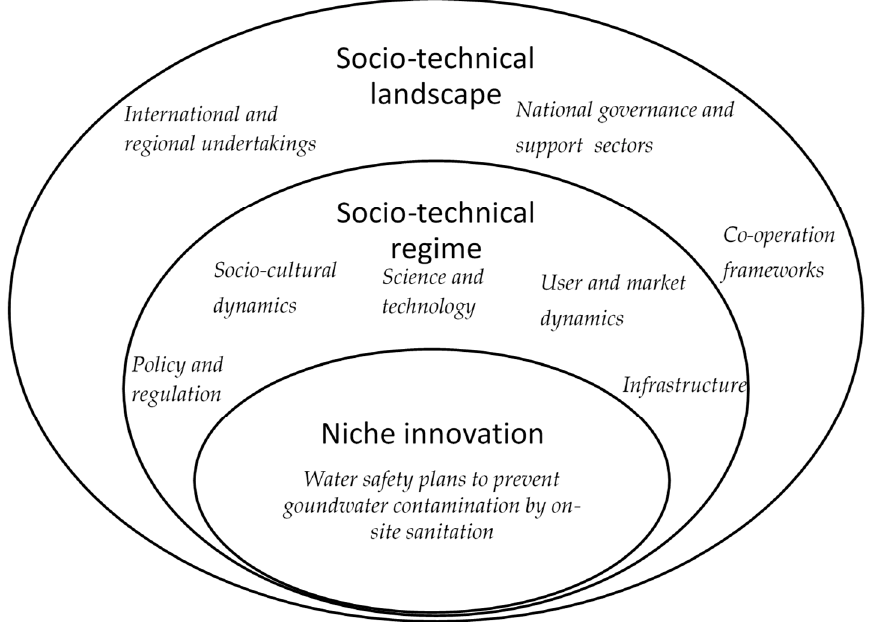
Figure 1. The analytical framework for analyzing socio-institutional drivers of on-site sanitation hazards to groundwater in the Bwaise informal settlement (Adapted from [27,33,38]).